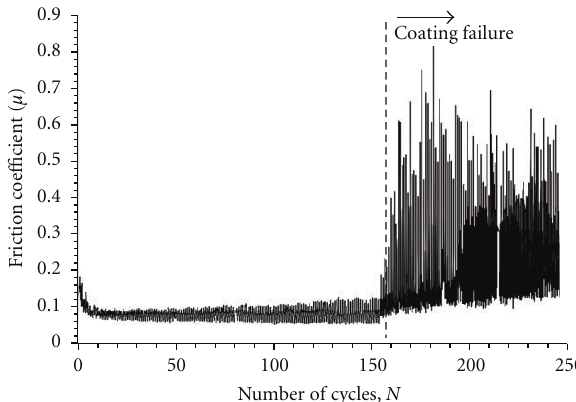
Figure 6: Friction coe ffi cient-number of cycles curve for the Ti 0 . 34 Al 0 . 66 N coating illustrating the increase in friction when coating failure